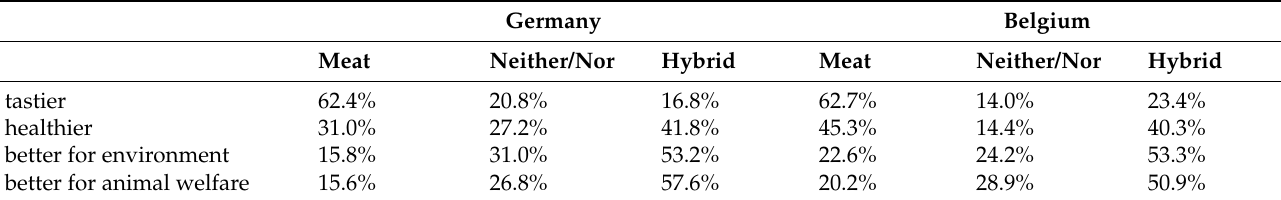
Table 11. Perception meat vs.